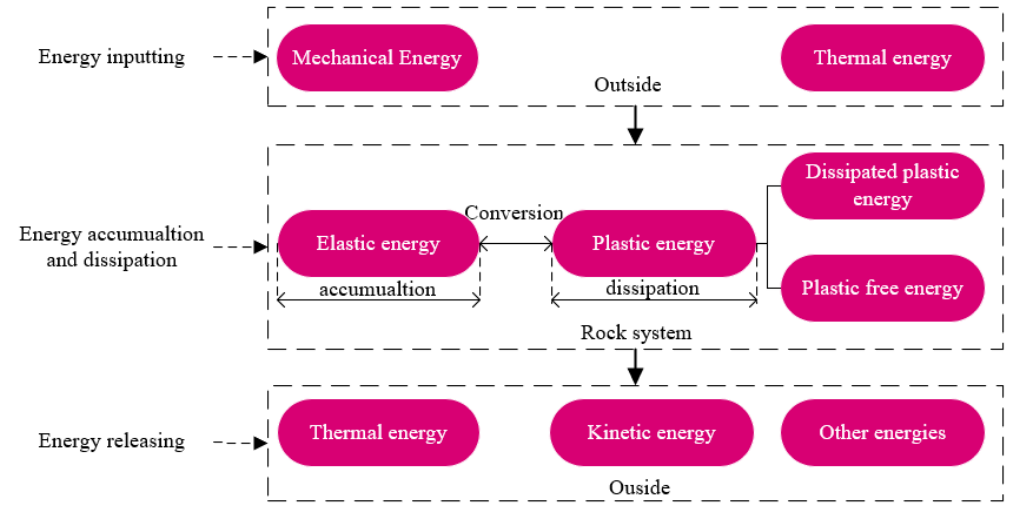
Figure 6. Forms of energy conversion of rock under cyclic loading and unloading.